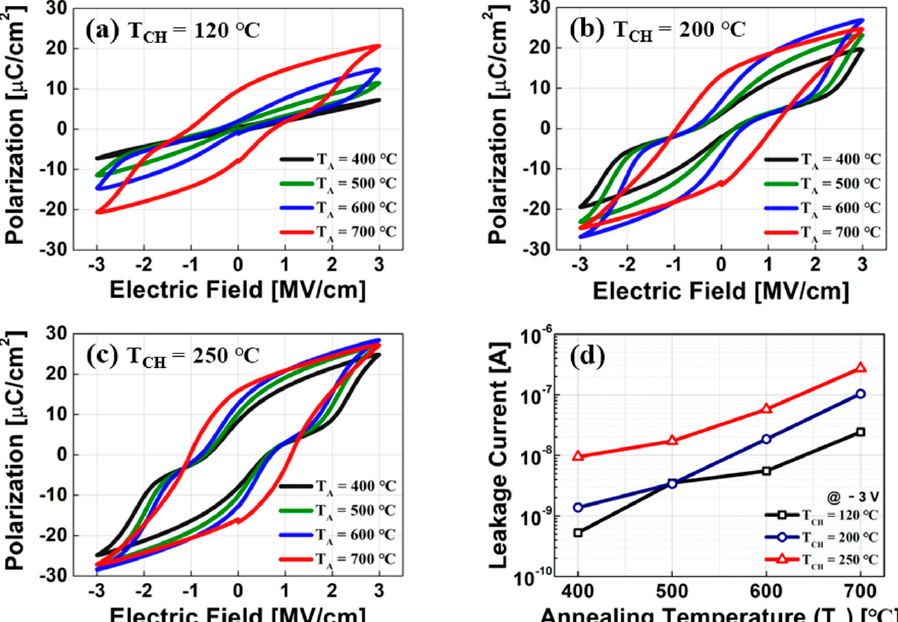
Figure 2. Measured polarization vs. electric field of TiN/HZO/TiN capacitor in which the HZO layer was deposited at the chamber temperature of ( a ) 120 ◦ C, ( b ) 200 ◦ C, and ( c ) 250 ◦ C. Note that four different annealing temperatures (T A = 400~700 ◦ C) were used for better implementing the ferroelectric characteristics of the HZO layer. ( d ) Measured leakage current-vs.-annealing temperature for three different chamber temperatures. Note that the leakage current was measured with the voltage of − 3 V across the ferroelectric capacitor.